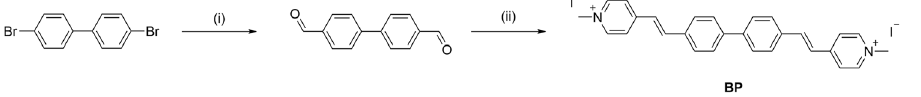
Figure 1. Synthesis and chemical structure of BP. (i) n -BuLi, N,N ′ -dimethylformamide, THF, − 78 °C, (ii) 1,4-dimethylpyridinium iodide, piperidine, chloroform/methanol (1:3), 60 °C.